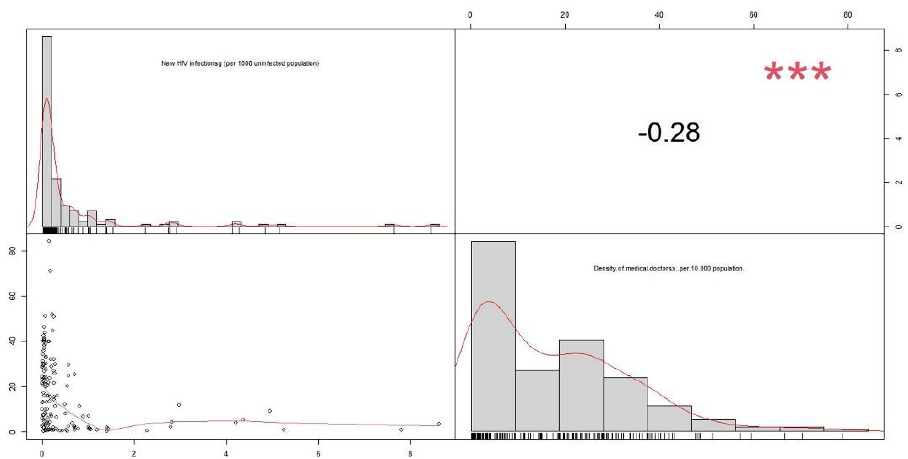
Figure 14. Big data analysis of correlation between medical doctor density according to STDs (HIV infection) rate.